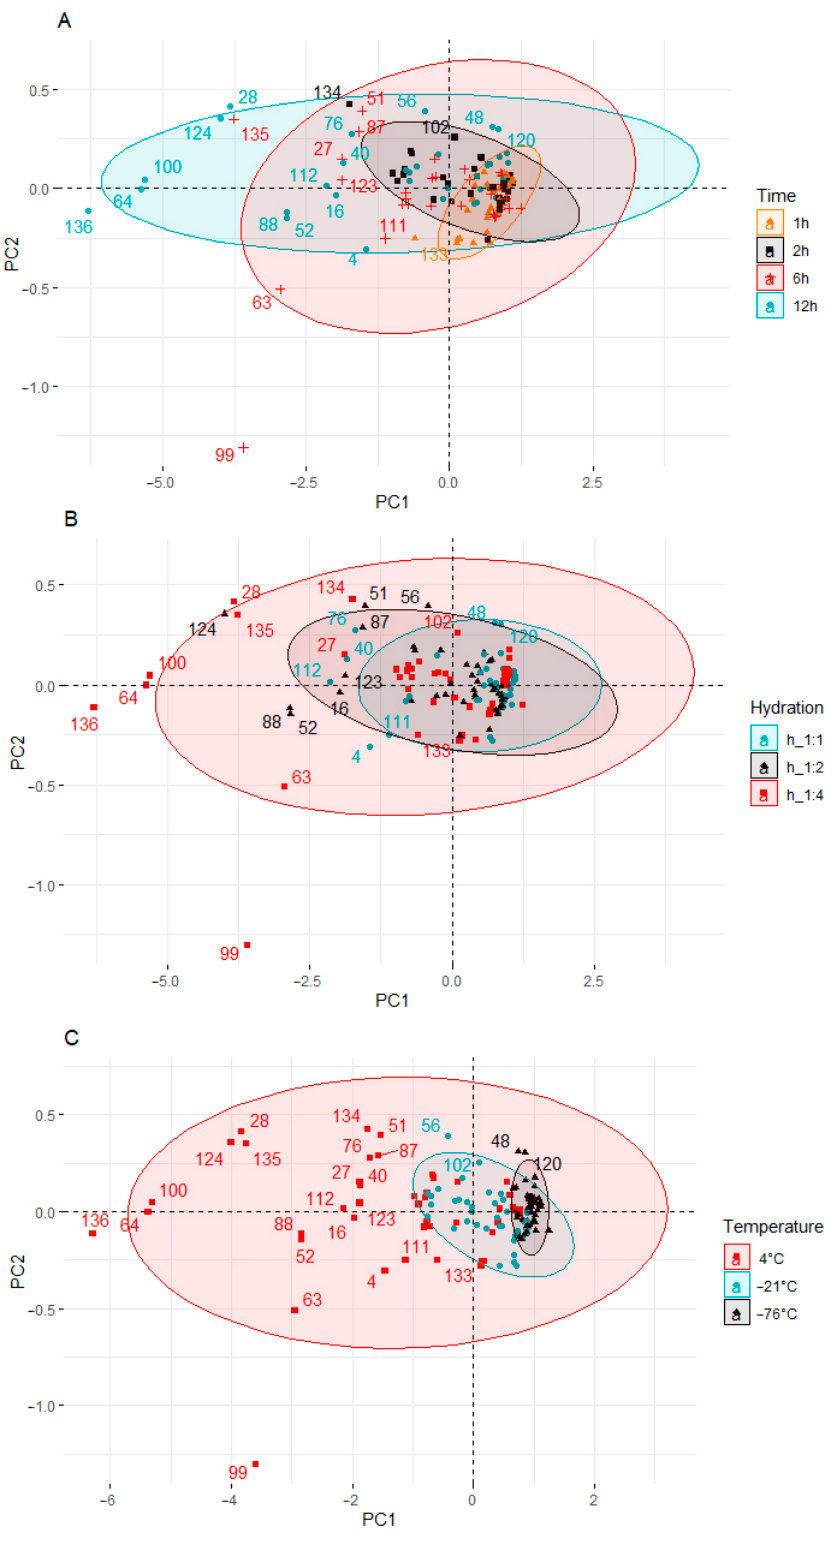
Figure 4. Principal component analysis (PCA) of the score plot of data from KIO 3 and KI content in pumpkin, broccoli, cauliflower, and carrot fortified at different times ( A ), hydration ratios ( B ), and temperatures ( C ).